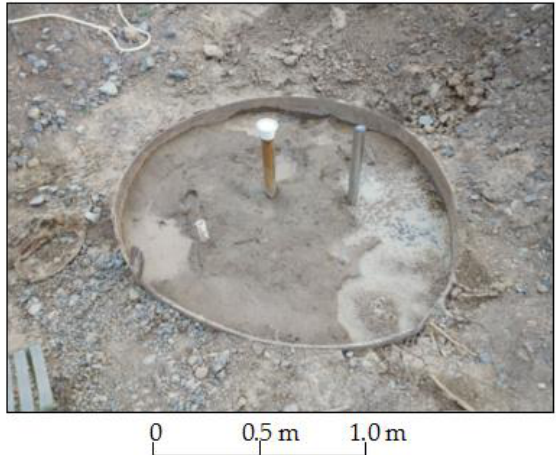
Figure 7. Illustration of the setup for plate load test.